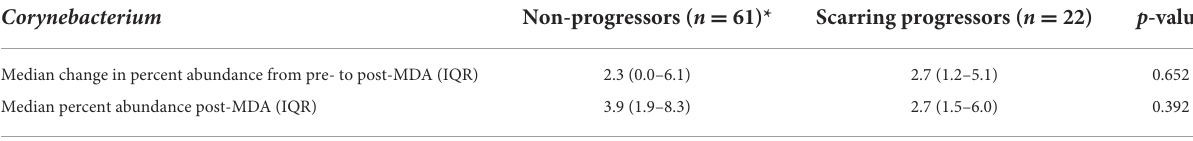
TABLE 3 No evidence of an association between Coryebacterium and scarring progression. Corynebacterium Non-progressors ( n =